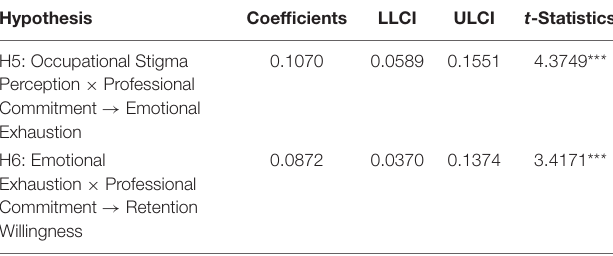
TABLE 9 | Moderating mediation effects of